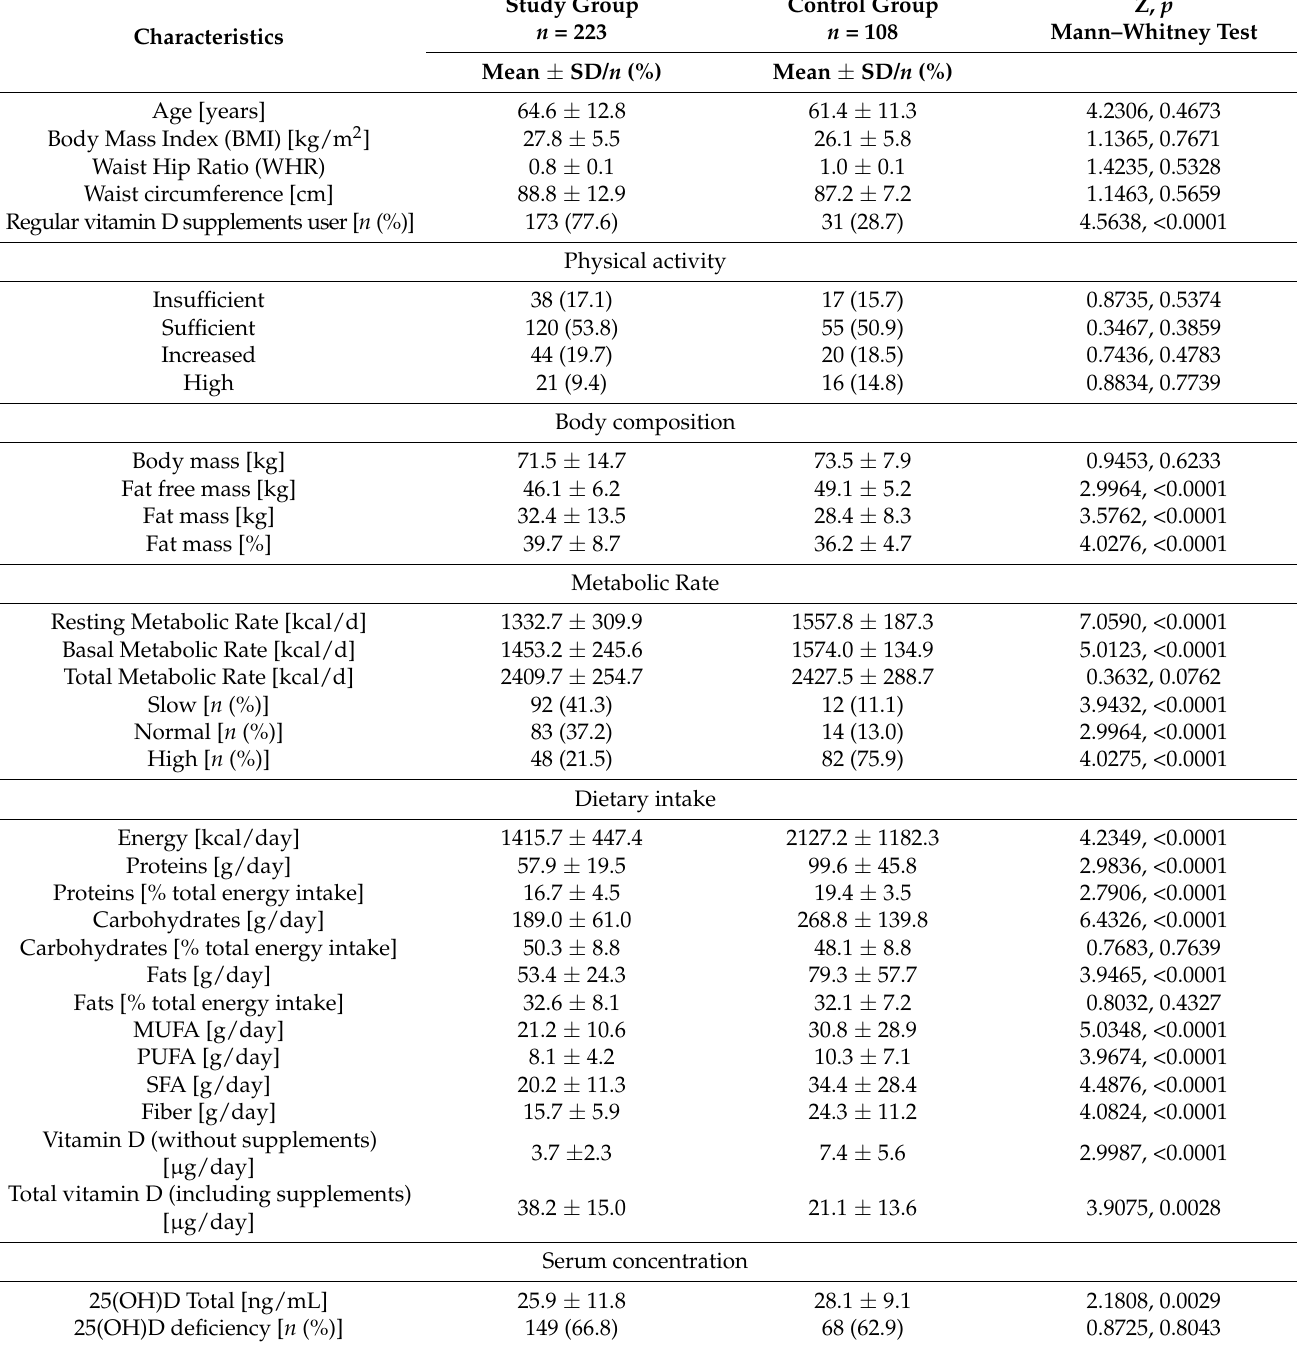
Table 1. Characteristics of the participating